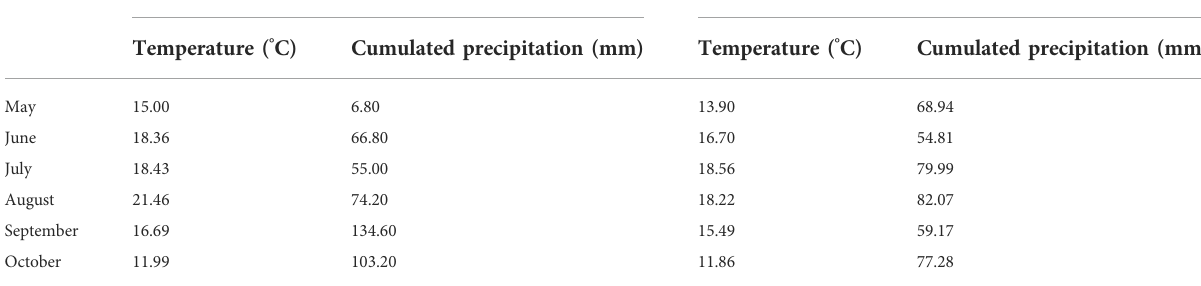
TABLE 2 The average temperature and precipitation during the maize growing season of 2020 and 2000 –